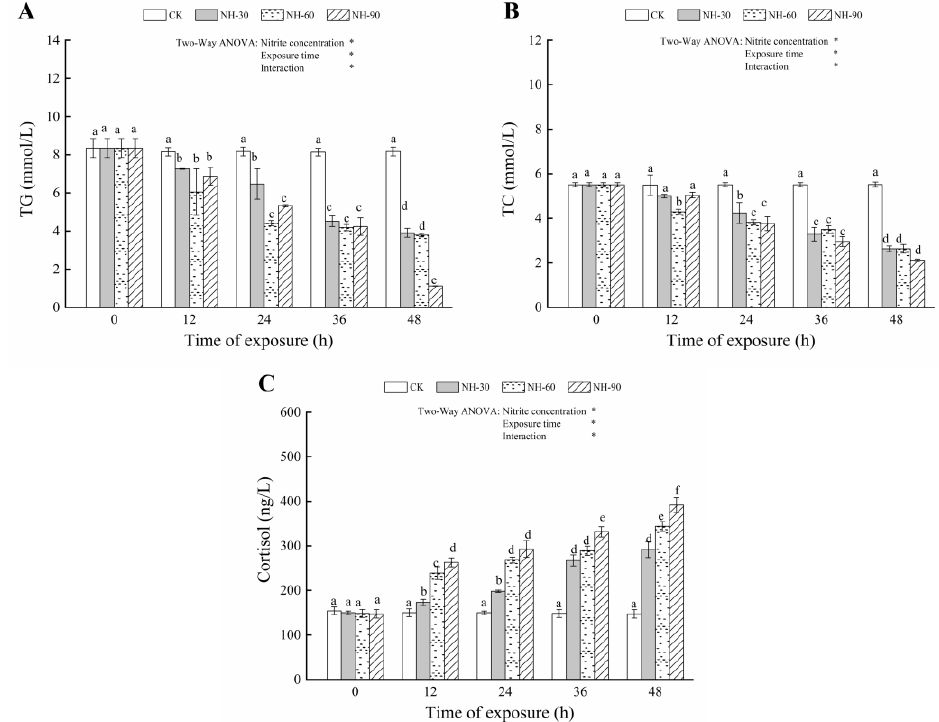
Figure 2. Changes in triglyceride (TG) ( A ), total cholesterol (TC) ( B ), and cortisol ( C ) levels in the serum of large yellow croaker exposed to nitrite at 29.36 mg/L (NO-29.36), 58.73 mg/L (NO-58.73), 88.09 mg/L (NO-88.09), and 0 mg/L (CK) for 48 h. Values are expressed as the mean ± SD. Different lowercase letters indicate significant differences ( p < 0.05) among groups. The CK nitrite group served as the control. * p <